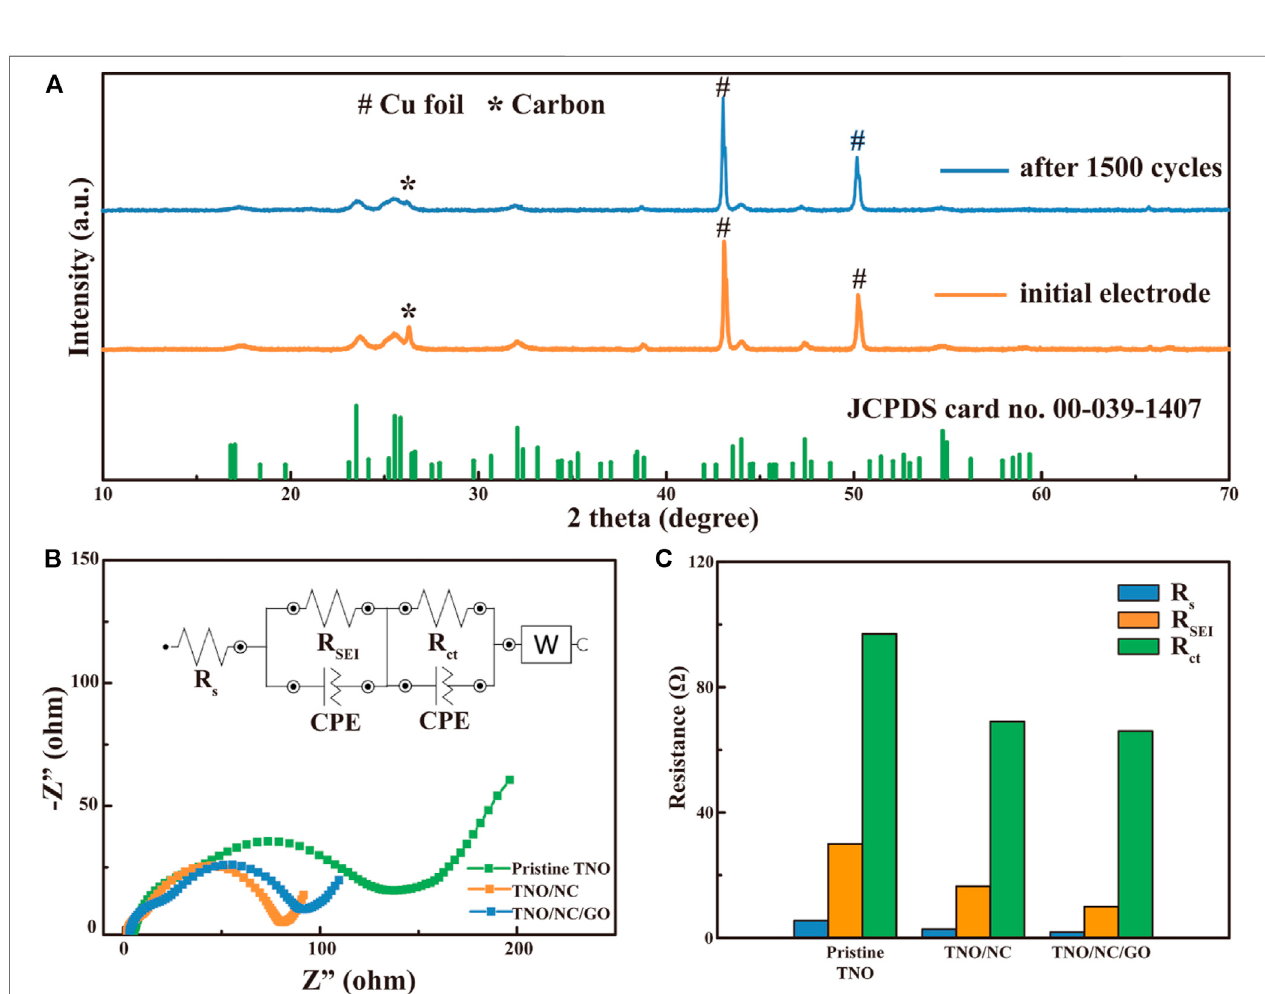
FIGURE8|(A) TheXRDpatternsofas-preparedandcycledTNO/NC/GOelectrodea, (B) NyquistplotsofpristineTNO,TNO/NC,andTNO/NC/GOcells;theinset exhibits the selected equivalent circuit to fi t the plots; (C) contribution of resistence of TNO, TNO/NC, and TNO/NC/GO electrode.